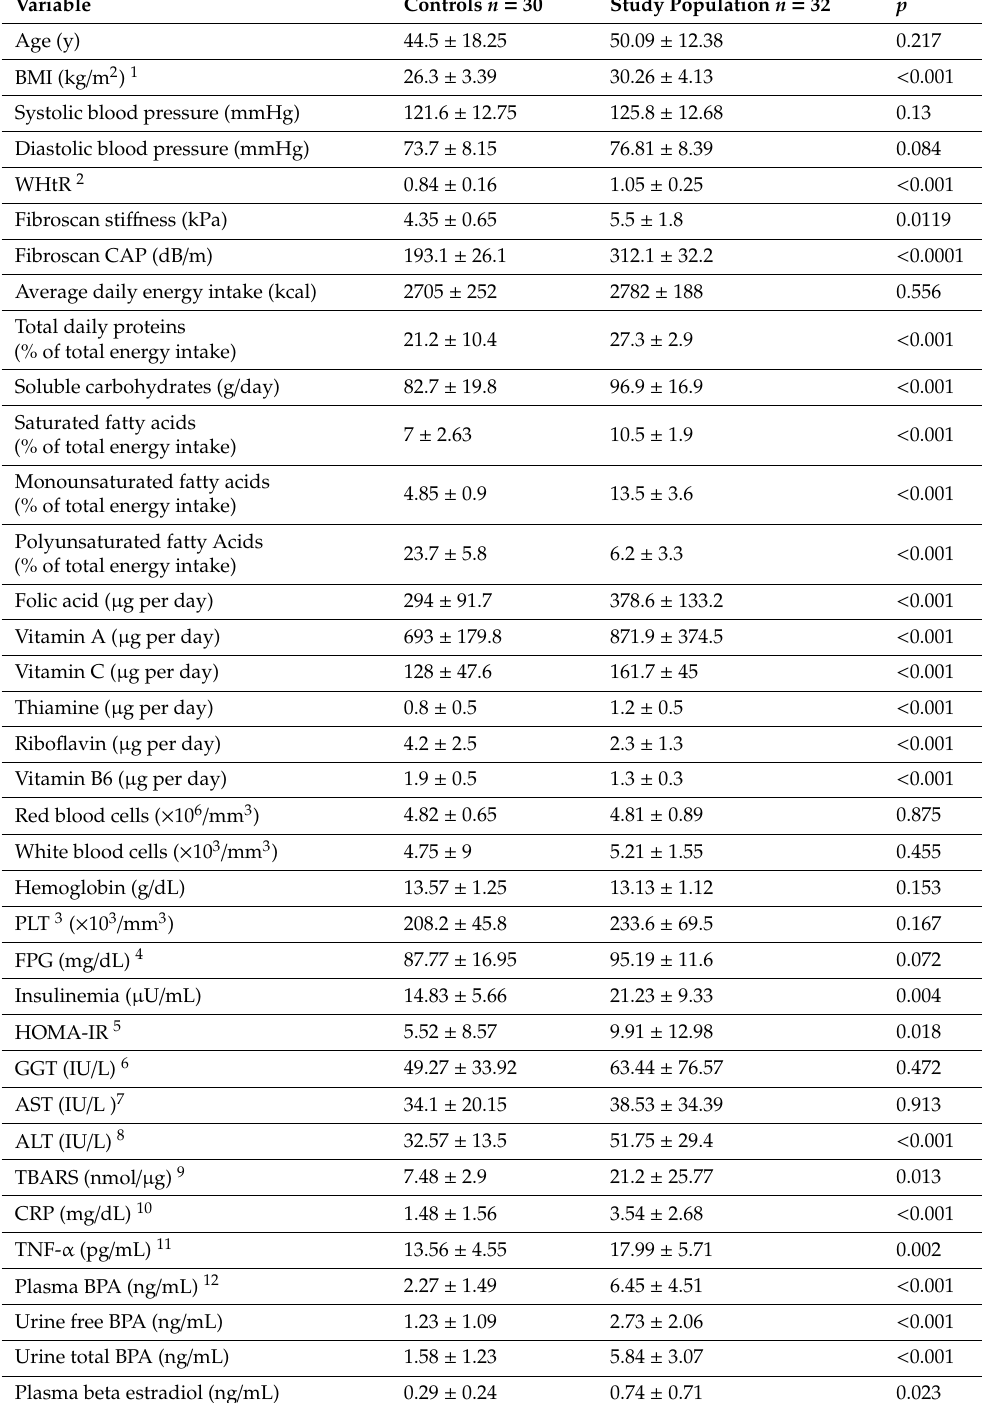
Table 1. Baseline characteristics of enrolled patients (mean ±